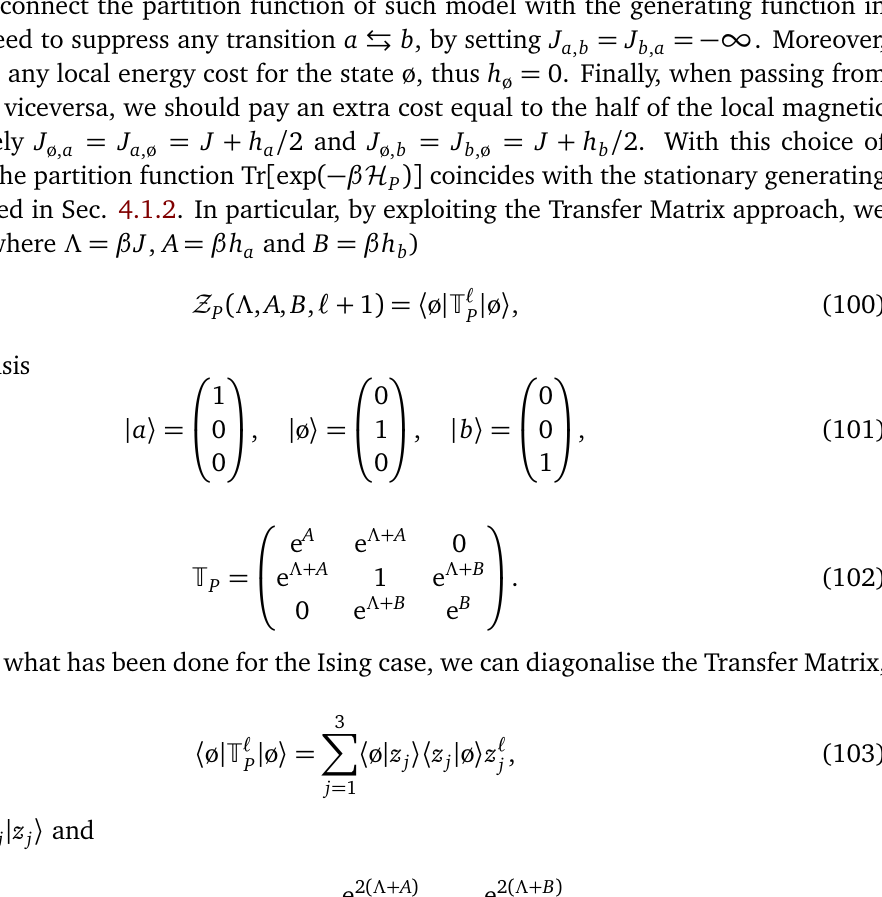
Figure 12: Contour plot of the real part of the eigenvalues z trix T , for λ ∈ [ − π , π ] and post-quench parameter α ∈ [ 1 / 2,1 ] . Notice P